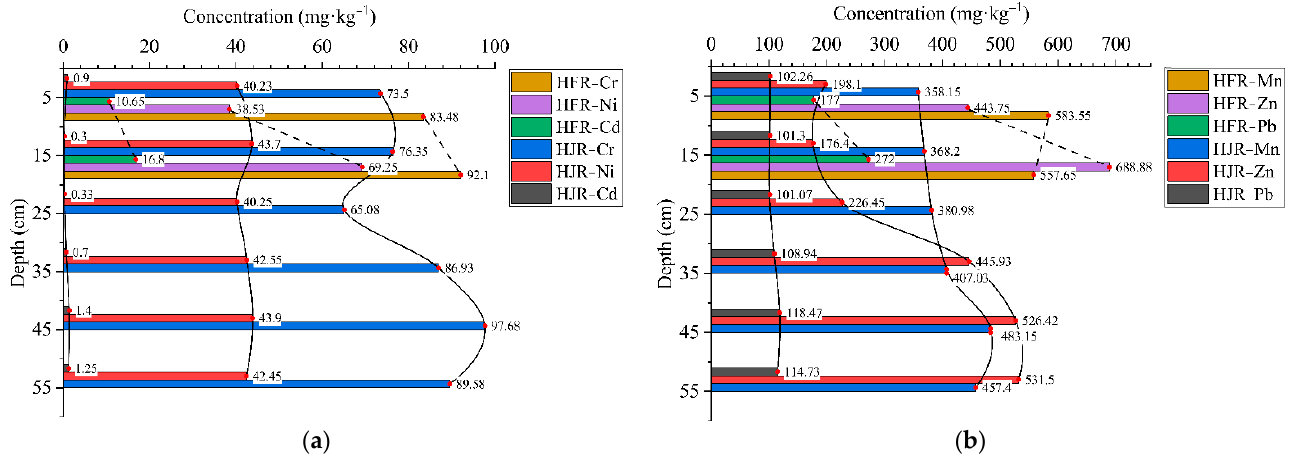
Figure 3. Heavy ‐ metal concentrations of sediment profiles in the HFR and HJR (Cr, Ni, and Cd ( a ); Mn, Zn, and Pb ( b